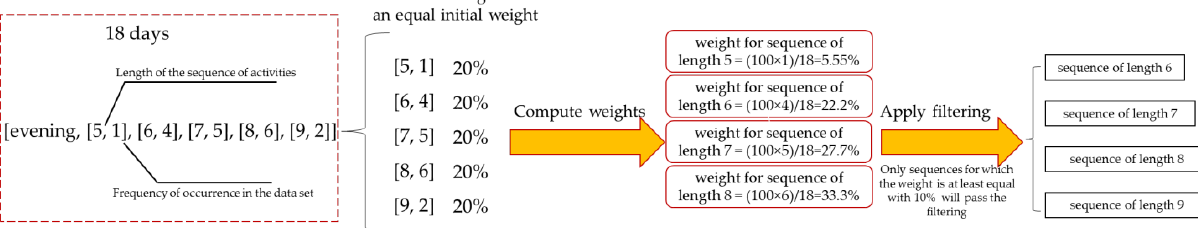
Figure 3. Filtering the sequences of activities based on the frequency of occurrence. Example for five different length sequences.